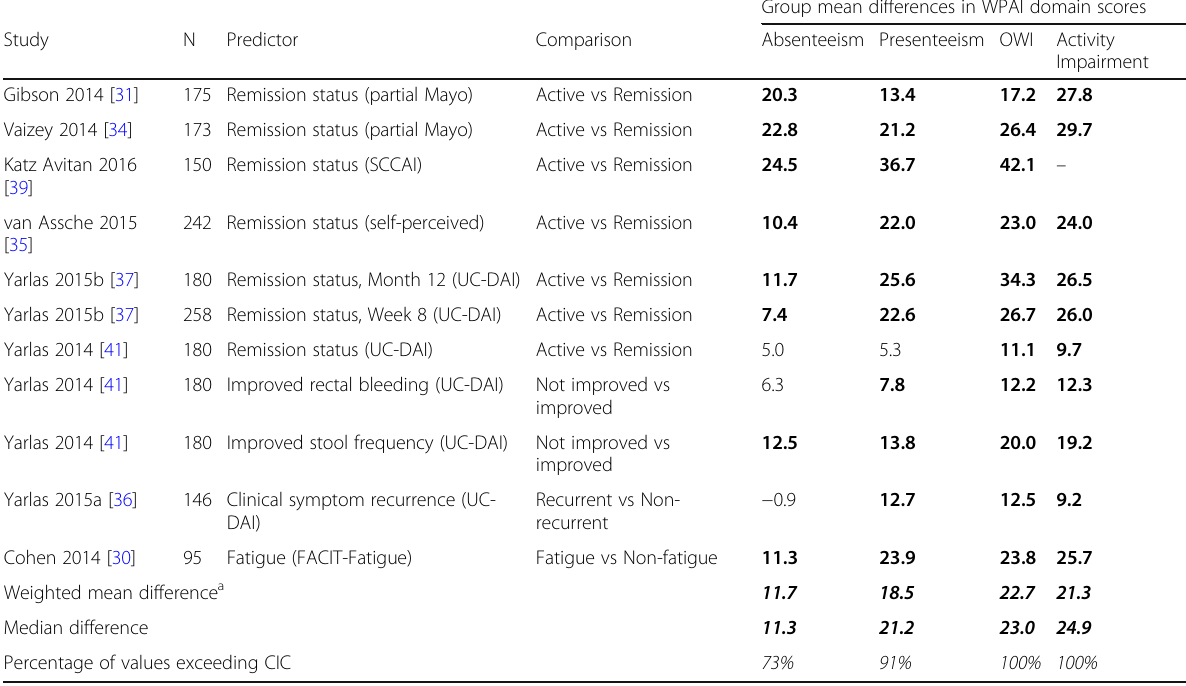
Table 5 Differences in WPAI scores between UC patient subgroups differing on health status